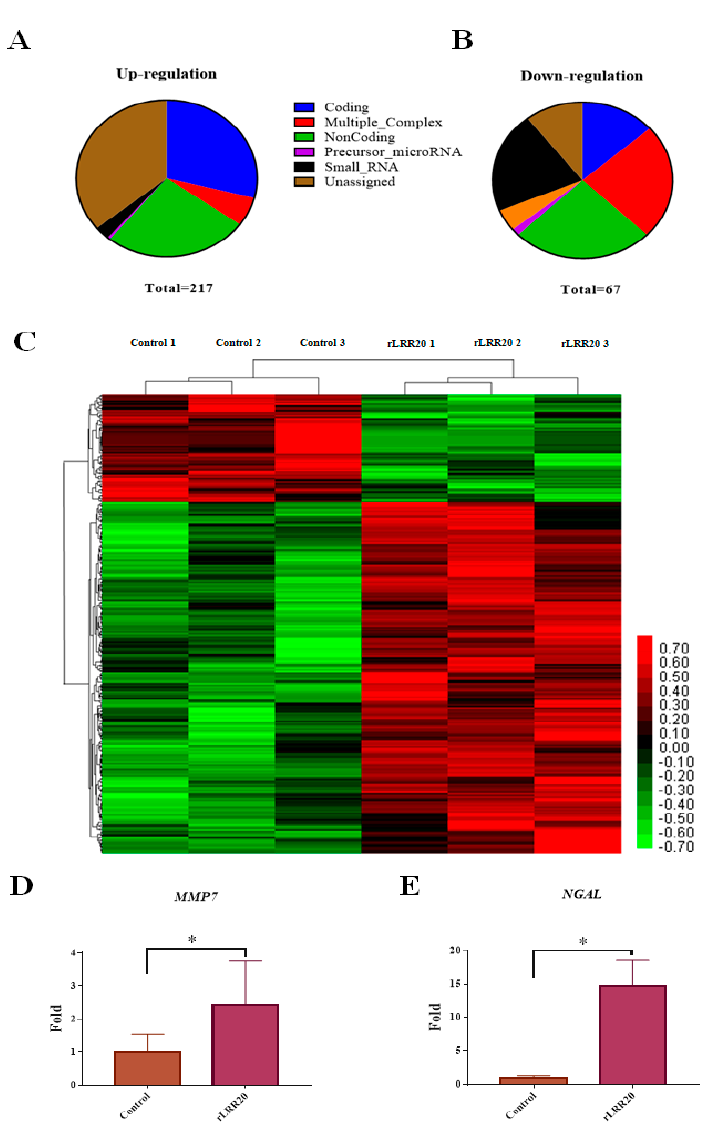
Figure 1. Overall representation of the effect of rLRR20 on the HK2s transcriptome profiles. The differential expression of coding and non-coding RNAs in HK2s. HK2s were treated with phosphate-buffered saline (control) or 10 µ M LRR20 for 8 h. Graphs show upregulated ( A ) and downregulated ( B ) genes between the rLRR20-treated and control groups. Six groups of genes are color-coded as follows: blue, coding genes; red, multigene complex; green, non-coding; purple, precursor microRNA; black, small RNA; brown, unassigned. ( C ) Heatmap of the genes regulated by rLRR20 in HK2s. The genes with fold change >2 and p -value < 0.05 were analyzed. Upregulation and downregulation are indicated in red and green colors, respectively. Treatment with rLRR20 upregulated the levels of MMP7 ( D ) and NGAL ( E ). * p <